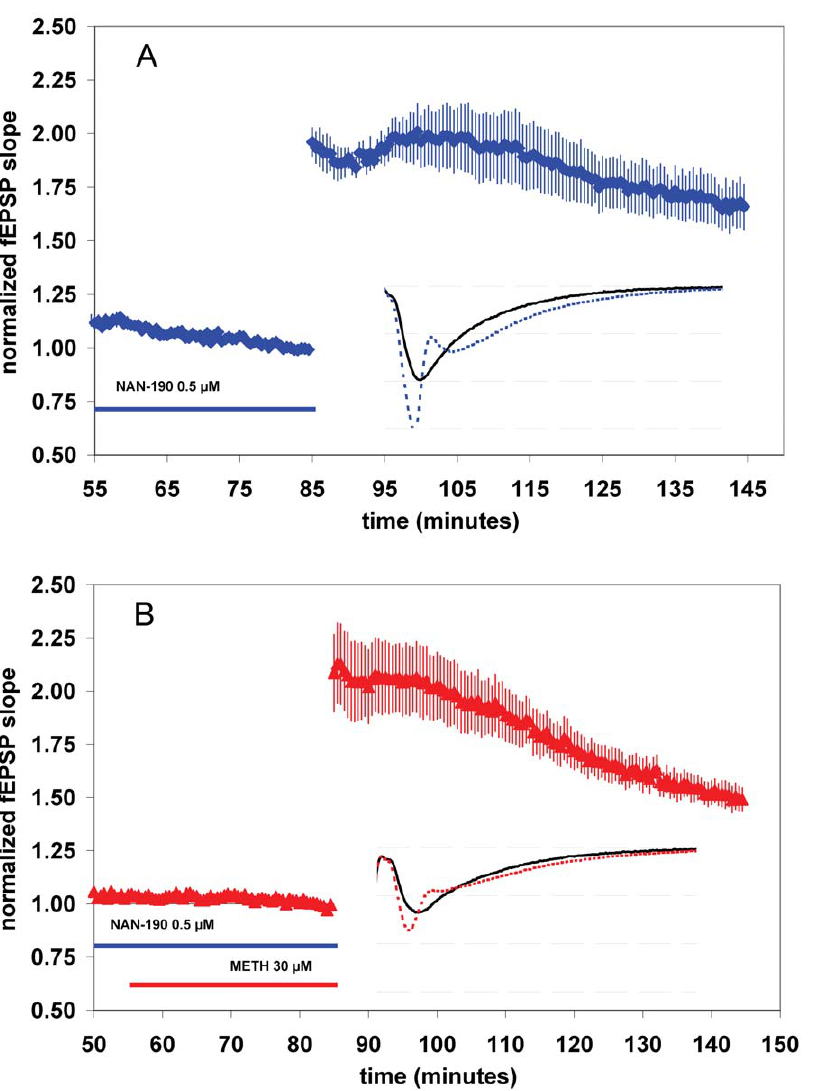
Figure 6. 5-HT1A serotonin antagonist NAN-190 blocks the effect of METH on baseline synaptic transmission. ( A,B ) Summary plot of normalized fEPSP slope measurements recorded in the CA1 region of the hippocampus. The red triangles (B) are from NAN-190 (0.5 m M) and METH (30 m M) treated slices; the blue diamonds (A) show results from NAN-190 (0.5 m M) experiments. Error bars are 6 SEM. Insets are 30-msec sweeps taken from representative experiments illustrating the average fEPSP 0–5 min prior to (solid line) and 55–60 min post-tetanus (dotted line, horizontal dashed lines are 1 mV apart).